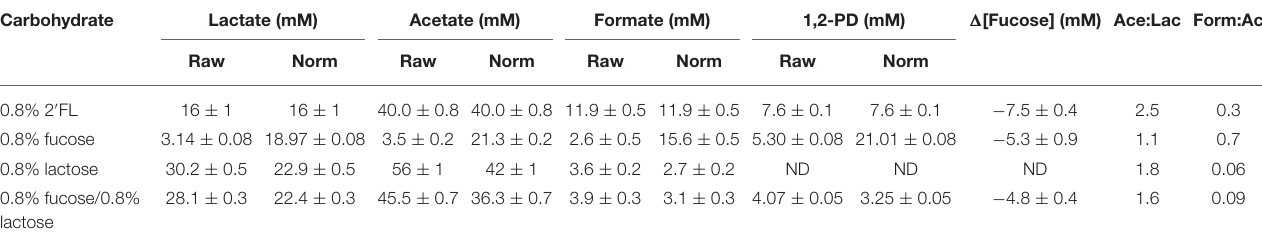
TABLE 2 | B. infantis extracellular metabolite production during growth on 2 ′ fucosyllactose is similar to that both in co-fermentation of fucose and lactose and on fucose and lactose as sole carbohydrates.